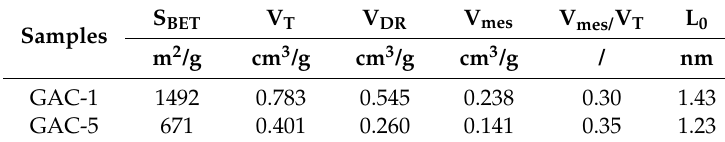
Table 3. Characterization of the porous structure of GAC-1 and GAC-5 by the N 2 adsorption technique.